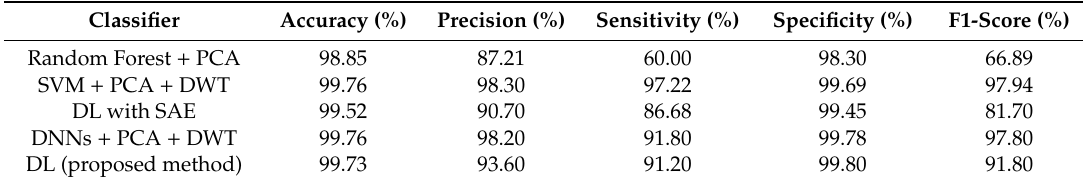
Table 8. Selected method for the benchmarking proposed method.